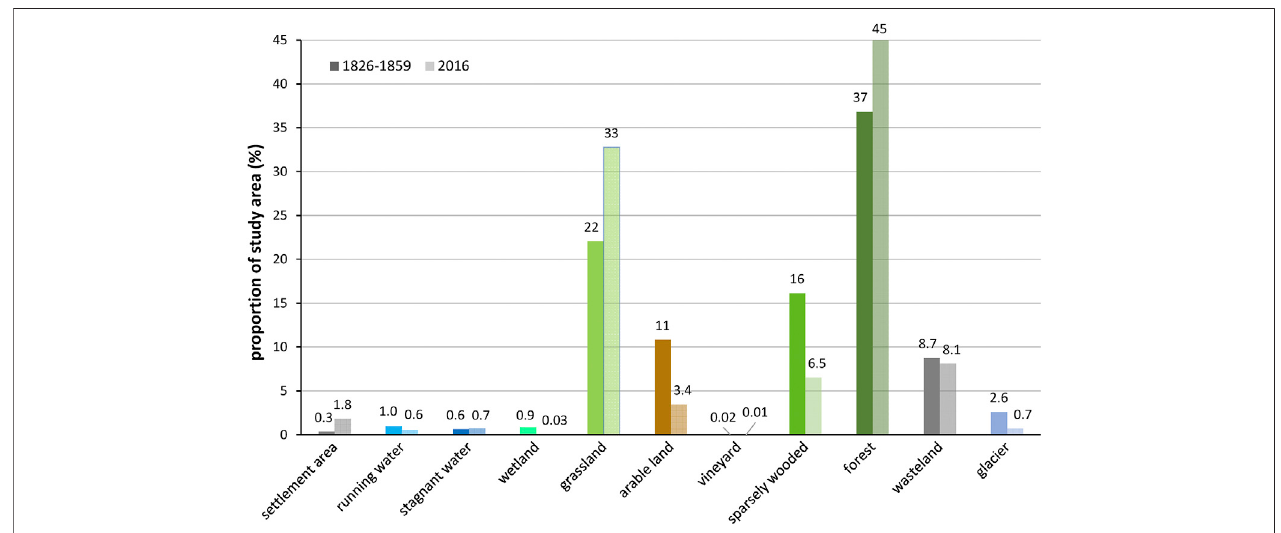
FIGURE 2 | Proportions of the land cover/use types in the Austrian catchments of the rivers Rhine, Salzach and Drava (%) (left column: 1826 – 1859, right: